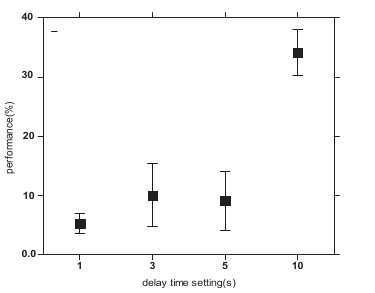
Figure 10. Percentage of power saving after using proposed mechanism